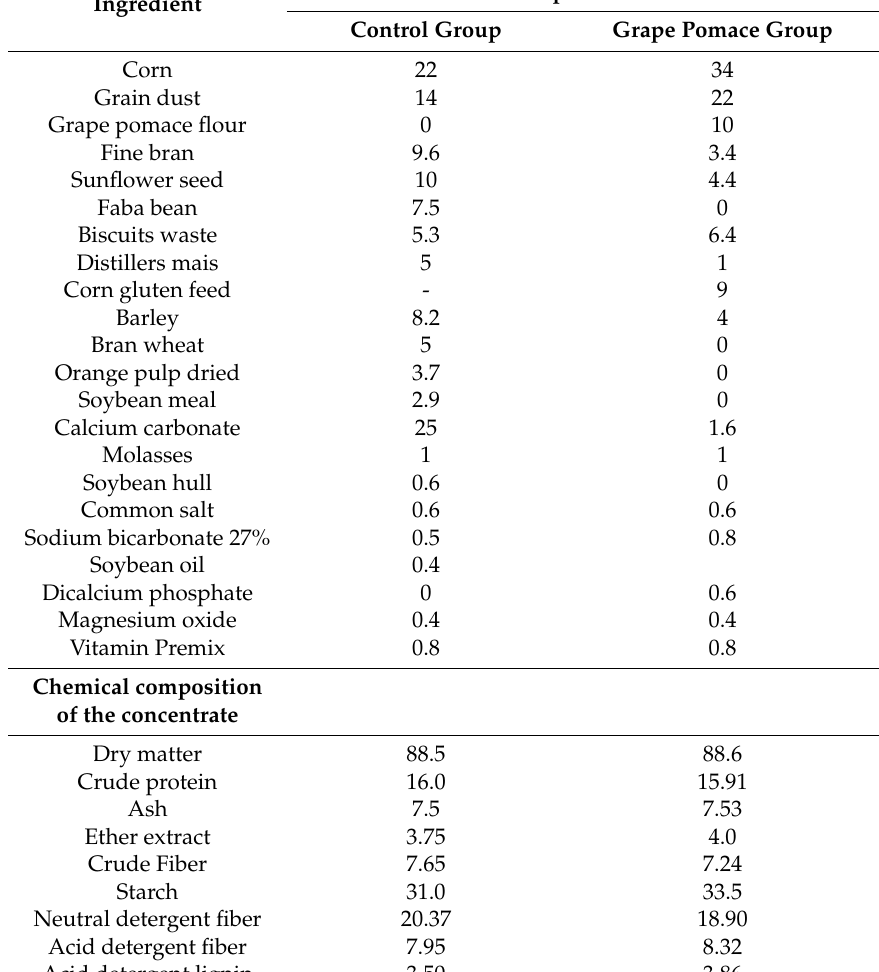
Table 2. Ingredients and chemical composition of the custom-formulated